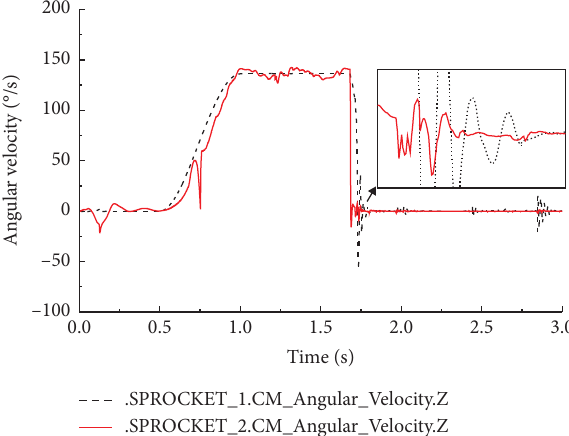
Figure 16: Sprocket rotational speed change curve after the chain is Figure 19. The change curve of the contact force in the X direction demonstrates that the contact force between the chain links is basically stable at approximately 5 · 10 4 N during a smooth operation. The contact force in the Y direction is small. When the time reaches 1.13 s, the connection contact between links 1 and 2 fails, and the contact forces in all directions become zero, thereby indicating that the action of sensor definition in the simulation script starts to execute.